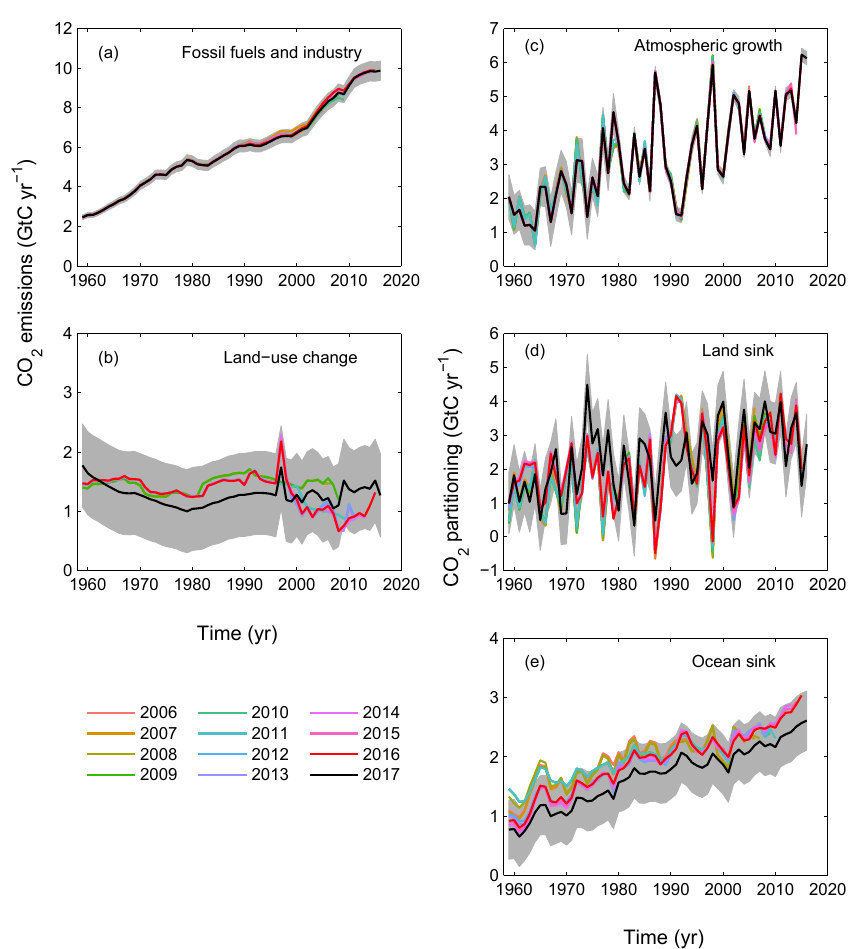
Figure 9. Comparison of global carbon budget components released annually by GCP since 2006. CO 2 emissions from (a) fossil fuels and industry ( E FF ) and (b) land-use change ( E LUC ), as well as their partitioning among (c) the atmosphere ( G ATM ), (d) the land ( S LAND ), and (e) the ocean ( S OCEAN ). See legend for the corresponding years, and Table 3 for references. The budget year corresponds to the year when the budget was first released. All values are in GtCyr − 1 . Grey shading shows the uncertainty bounds representing ± 1 σ of the current global carbon